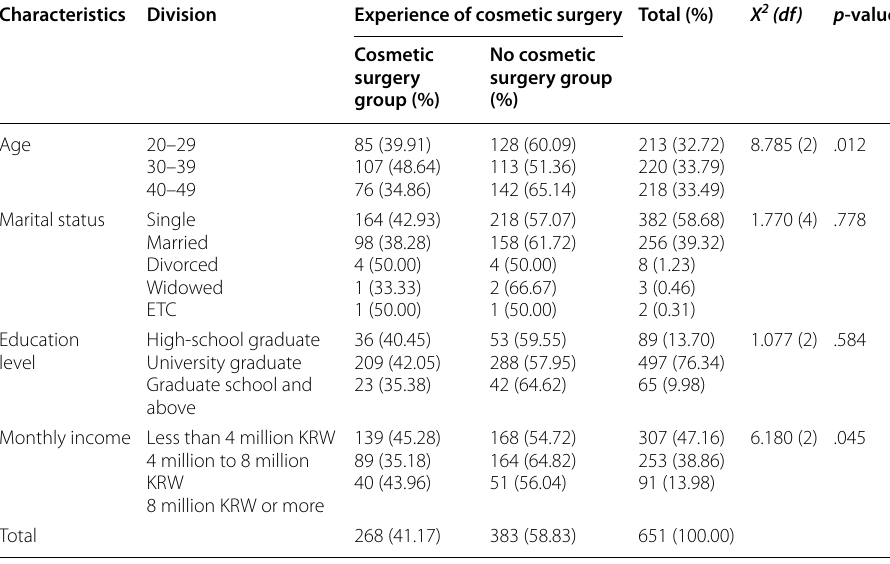
Table 2 Demographic